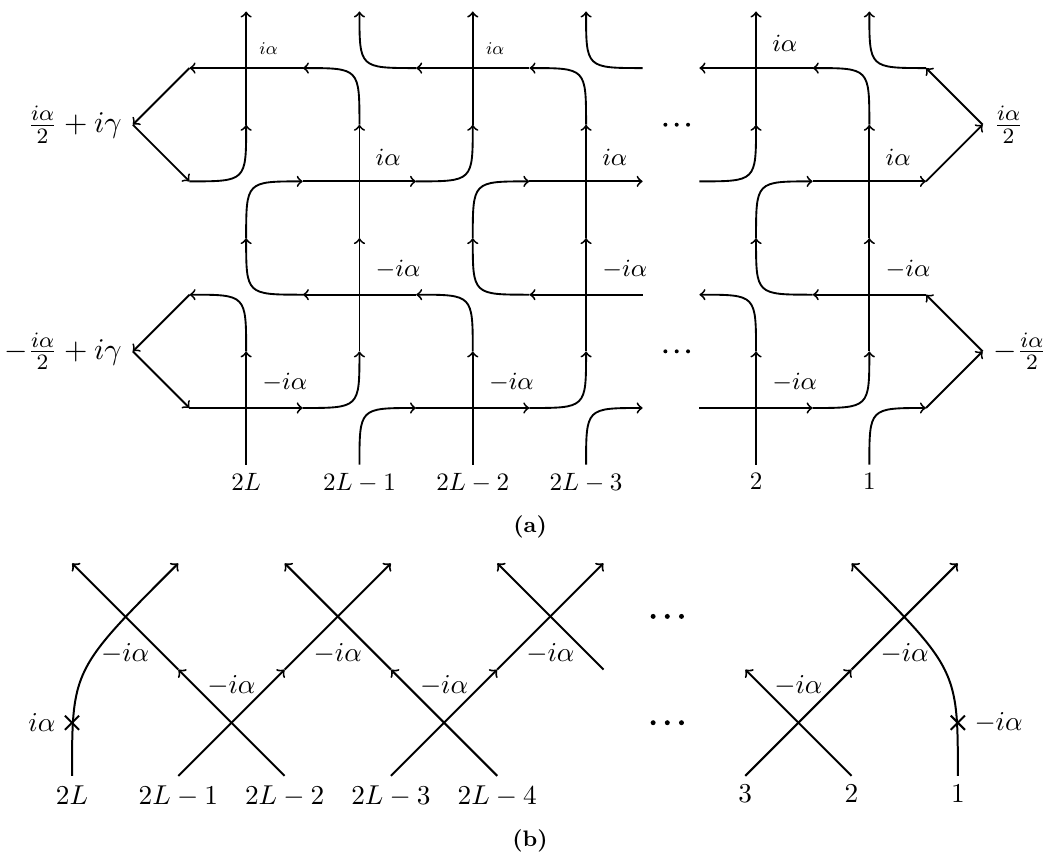
Figure 3 . (a) The transfer matrix T (2.17) evaluated at u 0 = iγ/ 2 , where many R -matrices become proportional to the permutation operator. Using the unitarity condition (2.2d) for the vertices in the second and third row, then between the first and fourth row one obtains the identity operator in the bulk. For the right boundary, one notes that the weights of the K − -matrices differ by a minus sign, leading to the identity operator if one takes the explicit form of K − in (2.7) into account. The left boundary will simplify to a loop-diagram, giving also the identity when evaluated using the explicit form of K + (2.8). (b) Graphical representation of τ u 0 , eq. (2.21). The tiny crosses stand for the operator insertion of exp [ ± iασ z / 2]